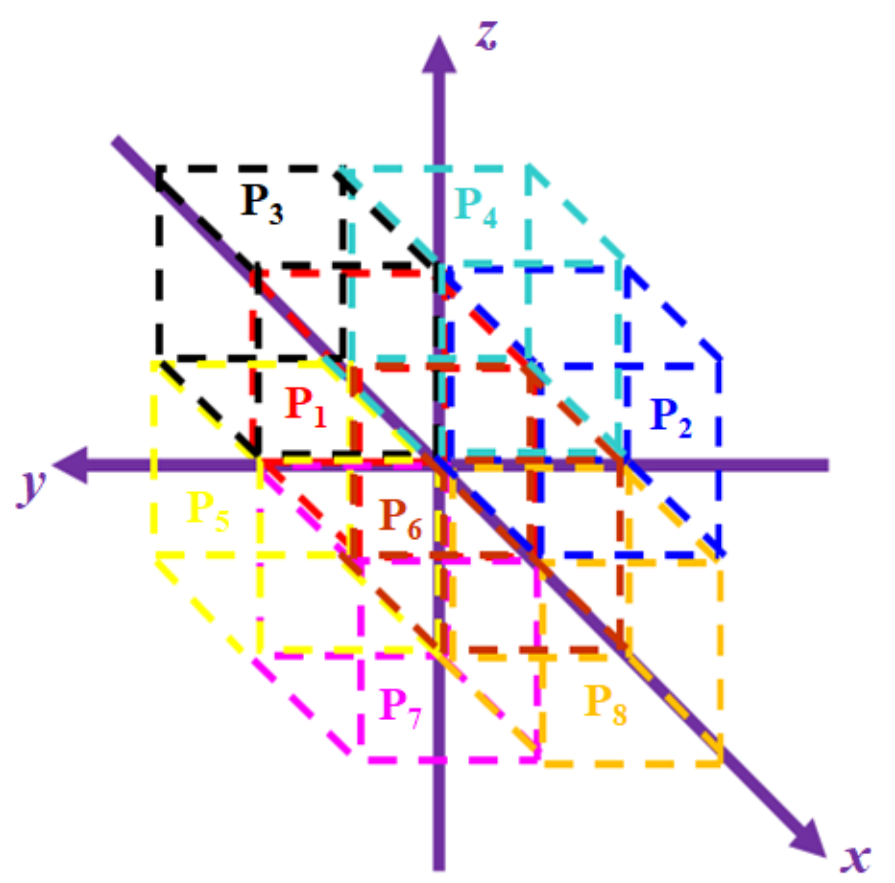
Figure 2. Schematic overview of the occurrence probability (from P 1 to P 8 ) associated with the oc- tants ζ